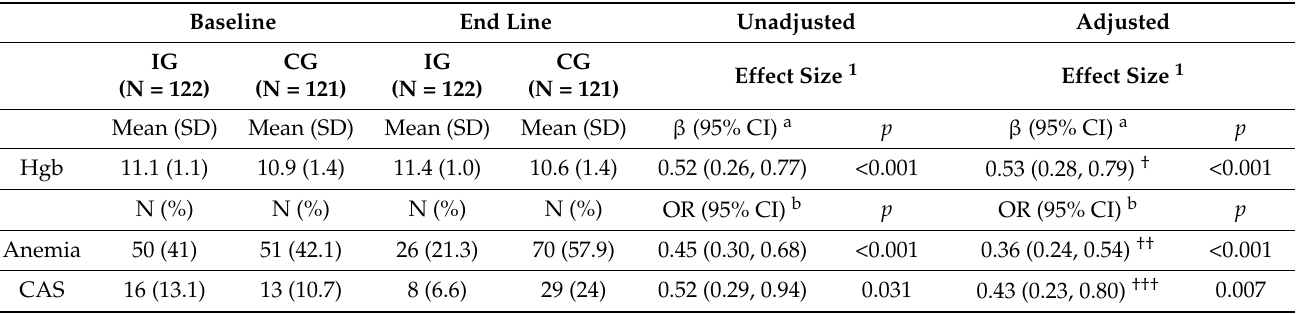
Table 2. Intervention effect on hemoglobin, anemia, and concurrent anemia and stunting